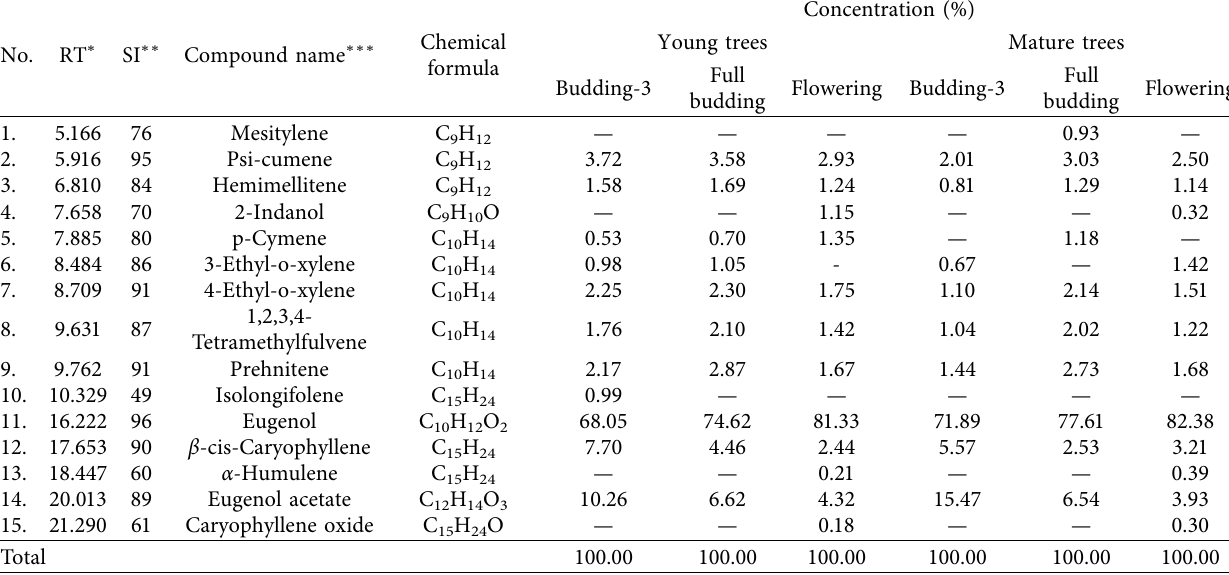
Table 2: Chemical composition and concentration of clove bud oil at different bud stages and tree ages.